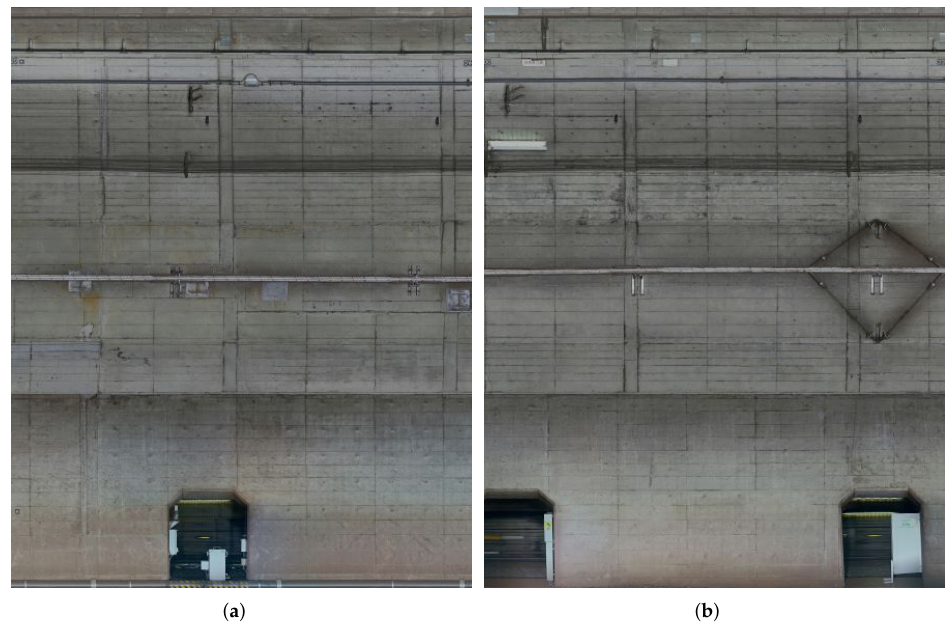
Figure 1. Examples of subway tunnel images used in this study. ( a , b ) are sample images taken from a visible camera for inspection. (Resolution: 1 mm/pixel, Image size: 12,088 × 10,000 pixels).